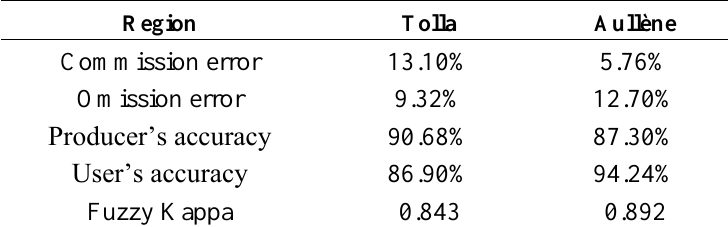
Table 2. External thematic accuracy assessment of the BSM_NOA